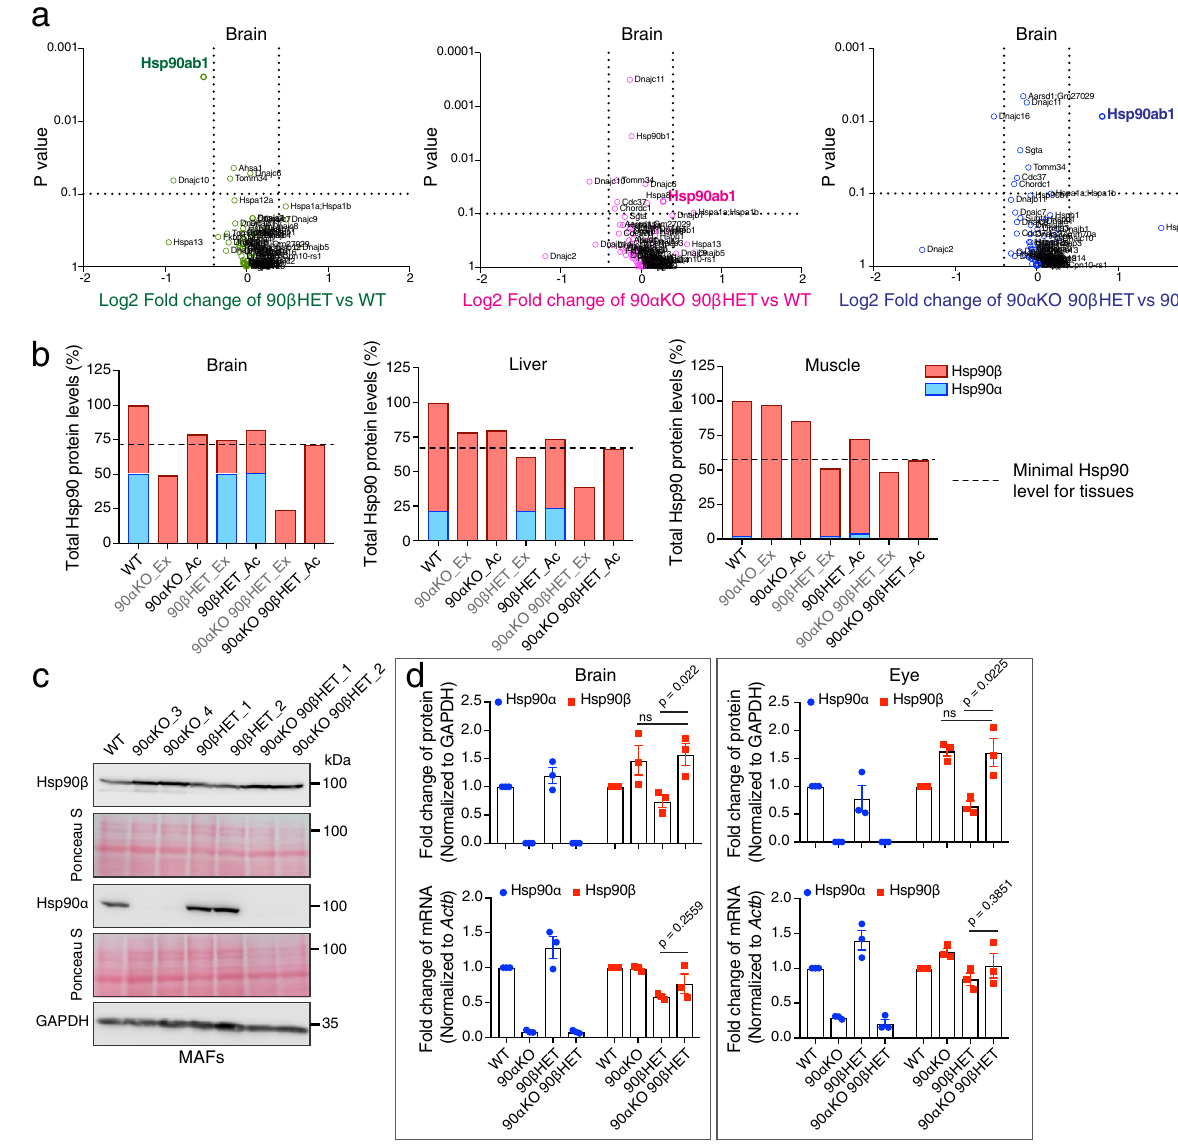
Fig. 2 | Increased Hsp90 β protein levels in 90 α KO 90 β HET survivor mice. a Volcano plot of the normalized fold changes of the Hsp70-Hsp90-related cha- perones, co-chaperones, and other stress-responsive proteins determined by quantitative label-free proteomic analysis of brain ( n =2 biologically independent samples).Log2foldchangeof>0.4or< − 0.4witha p -valueof<0.1wereconsidered to be signi fi cant differences for a particular protein. The comparisons between samples of different genotypes are shown in different colors. b Total Hsp90 pro- tein levels and relative proportions of the Hsp90 α and Hsp90 β isoforms (mea- sured by quantitative label-free proteomic analysis) for the indicated tissues of animals of the different genotypes. Ex, expected Hsp90 protein levels (these are mathematically derived and based on the observed Hsp90 allele-speci fi c con- tributions to total Hsp90); Ac, actual (observed) Hsp90 protein levels (derived from proteomic analyses). Total Hsp90 protein levels in WT samples were set to